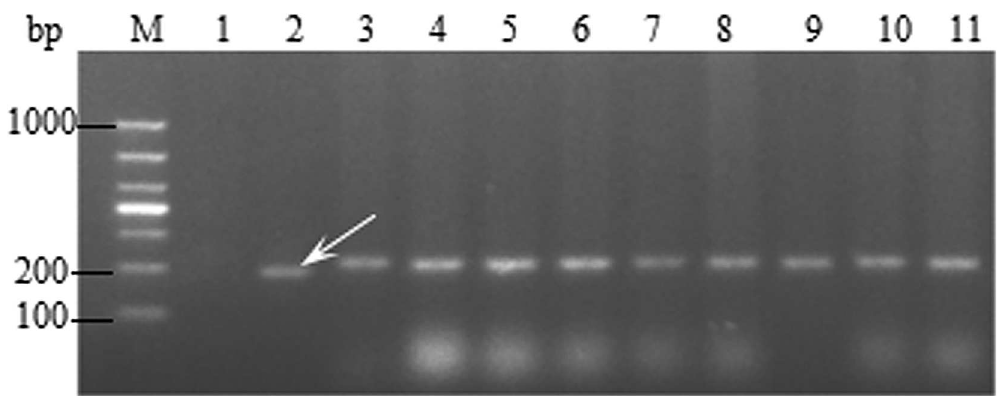
indicates1000 bp DNA ladder and white arrow indicatesthe position of the specific band.